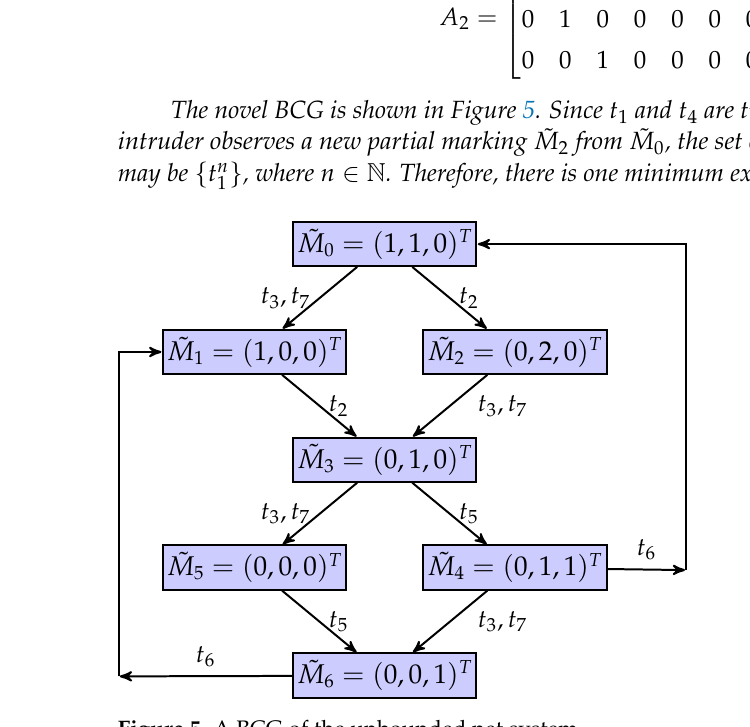
Figure 5. A BCG of the unbounded net